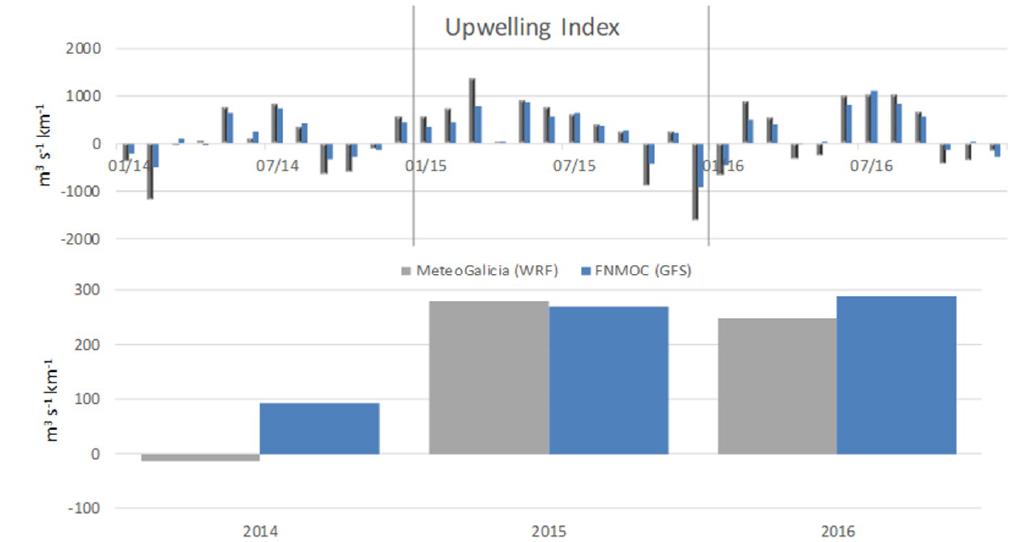
Figure 9. Upwelling index derived from WRF and GFS atmospheric models between 2014 and 2016. The Pearson correlation coe ffi cients ( r ) obtained were very high and always superior to 0.86, indicating a very strong relationship between MOHID and the remote sensing products (Table 5). Regarding BIAS , the di ff erences between modelling results and products data were always low and varied between − 0.407 and − 0.102 (Table 5). For all comparison, the RMSE error was always lower than 1 and higher than 0.7, which also indicates high accuracy of MOHID results. These results show that MOHID captures well the dominant pattern of the horizontal superficial distribution of the surface seawater temperature. Table 5. Surface seawater temperature from satellite data. Data summary and results of statistics used to assess the level of agreement between remote sensing data and modelling results. n–number of observations; r –correlation coefficient; BIAS –Average bias; RMSE –Root mean square error.